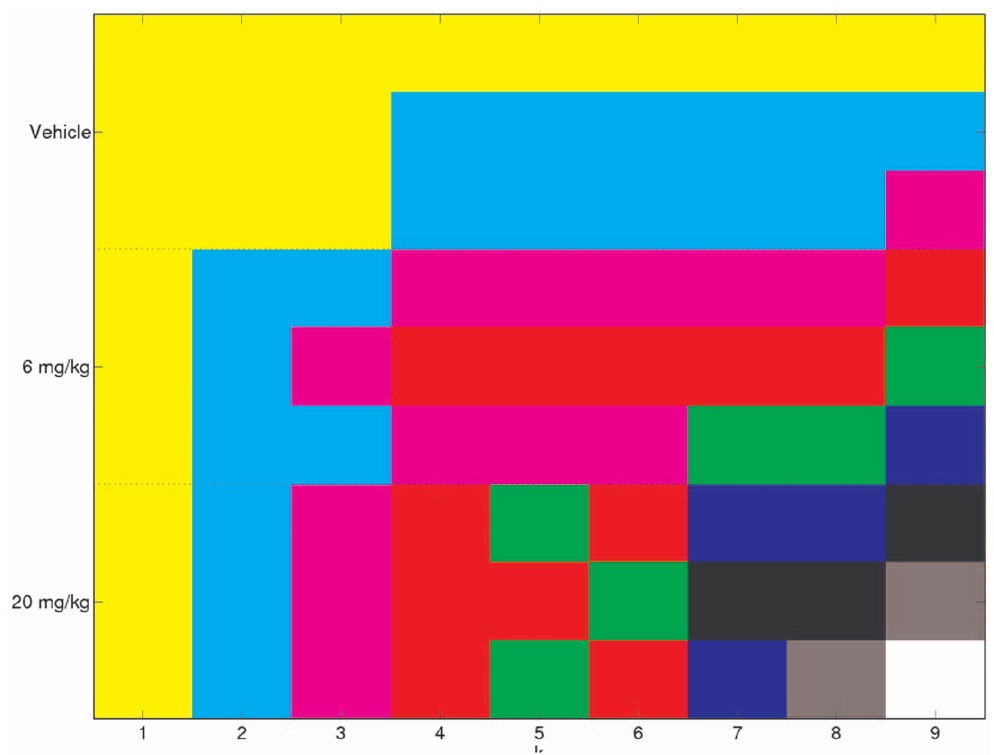
Figure 6. Factorisation of the four separate tissue types simultaneously. The clustering of the mice for k ~ 1, ... ,9 ; colour indicates cluster number. One ‘‘misclassification’’ is found for several values of k . This involves the mouse showing a toxic response to the lower (6 mg/kg) dose of PPAR agonist, as discussed in section .